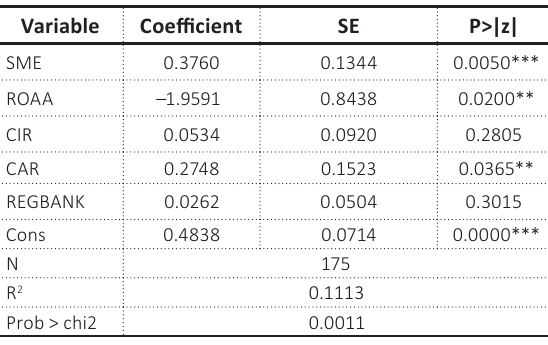
Table 7. Efficiency model